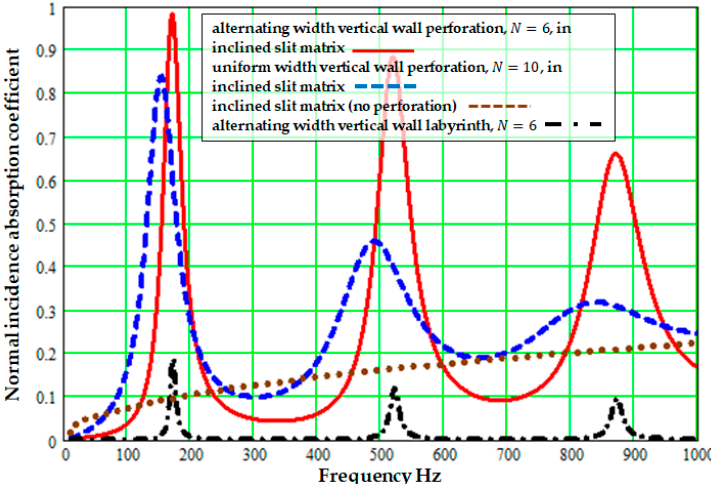
Figure 7. Normal incidence absorption coefficient spectra predicted for 0.045 m thick hard-backed layers consisting of either alternating width ( w = 1 mm, b = 3 mm, l = 40 mm, δ = 7, N = 6, continuous line) or constant width ( w = 1 mm, b = 3 mm, l = 40 mm, N = 10, broken line) vertical-wall labyrinth in a slit pore matrix (0.04 mm wide slits at 70 ◦ to the normal, porosity 0.75). The dash-dot line is the prediction for the same non-uniform labyrinthine perforation in a non-porous solid and the dotted line is the prediction for the slit pore medium (no perforation).